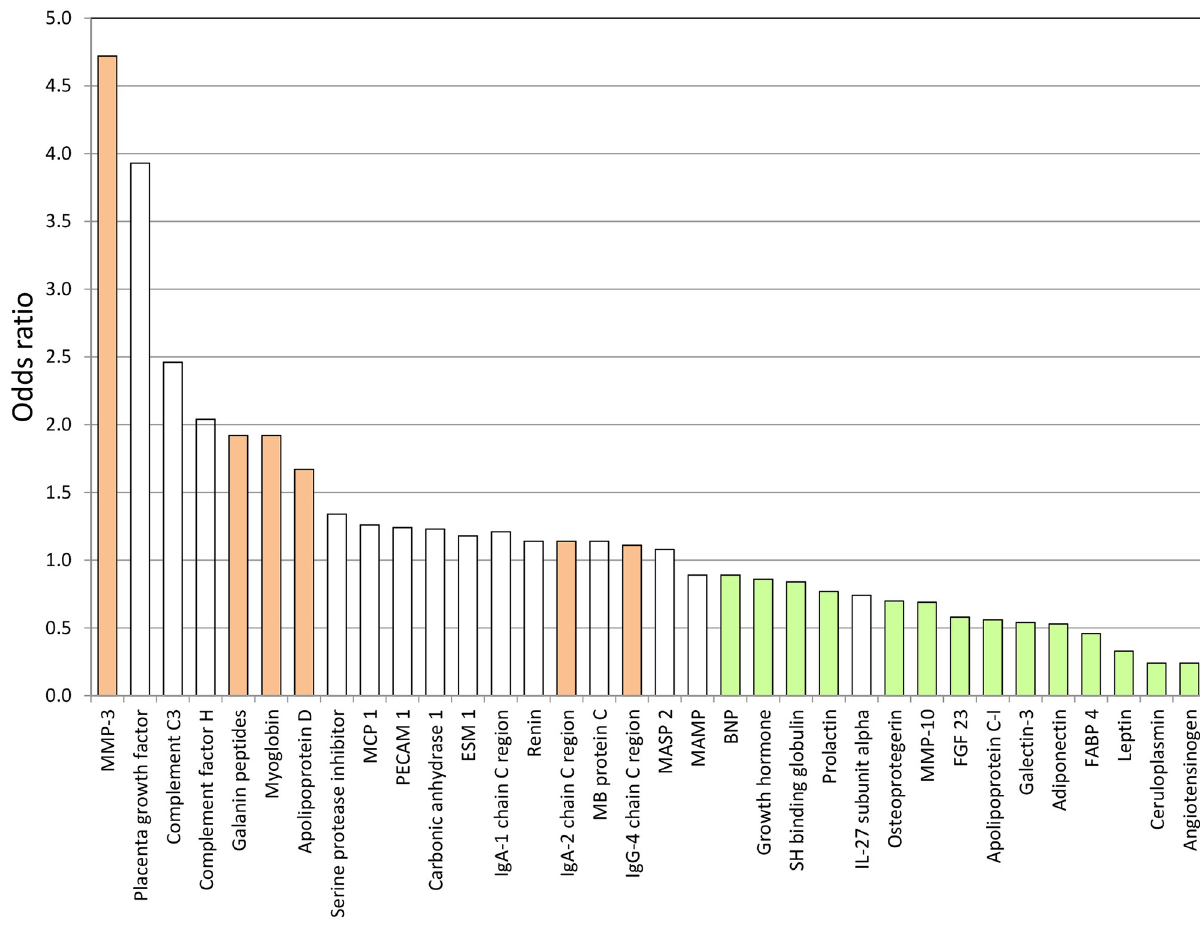
Fig 1. Biomarkers with discriminatory value regarding sex according to results from the Lasso analysis. The red-shaded and green-shaded columns indicate biomarkers with higher concentrations in men (n = 6) and women (n = 14), respectively, according to Mann-Whitney tests with correction for multiple testing. MMP-3: Matrix metalloproteinase-3; MCP 1: Monocyte chemotactic protein 1; PECAM 1: Platelet endothelial cell adhesion molecule 1; ESM-1: Endothelial cell-specific molecule-1; MB: Mannose-binding; MASP 2: Mannan-binding lectin serine protease 2; MAMP: Membrane-bound aminopeptidase P; BNP: B-type natriuretic peptide; SH: Sex hormone; IL: Interleukin; FGF 23: Fibroblast growth factor 23; FABP 4: Fatty acid-binding protein 4.